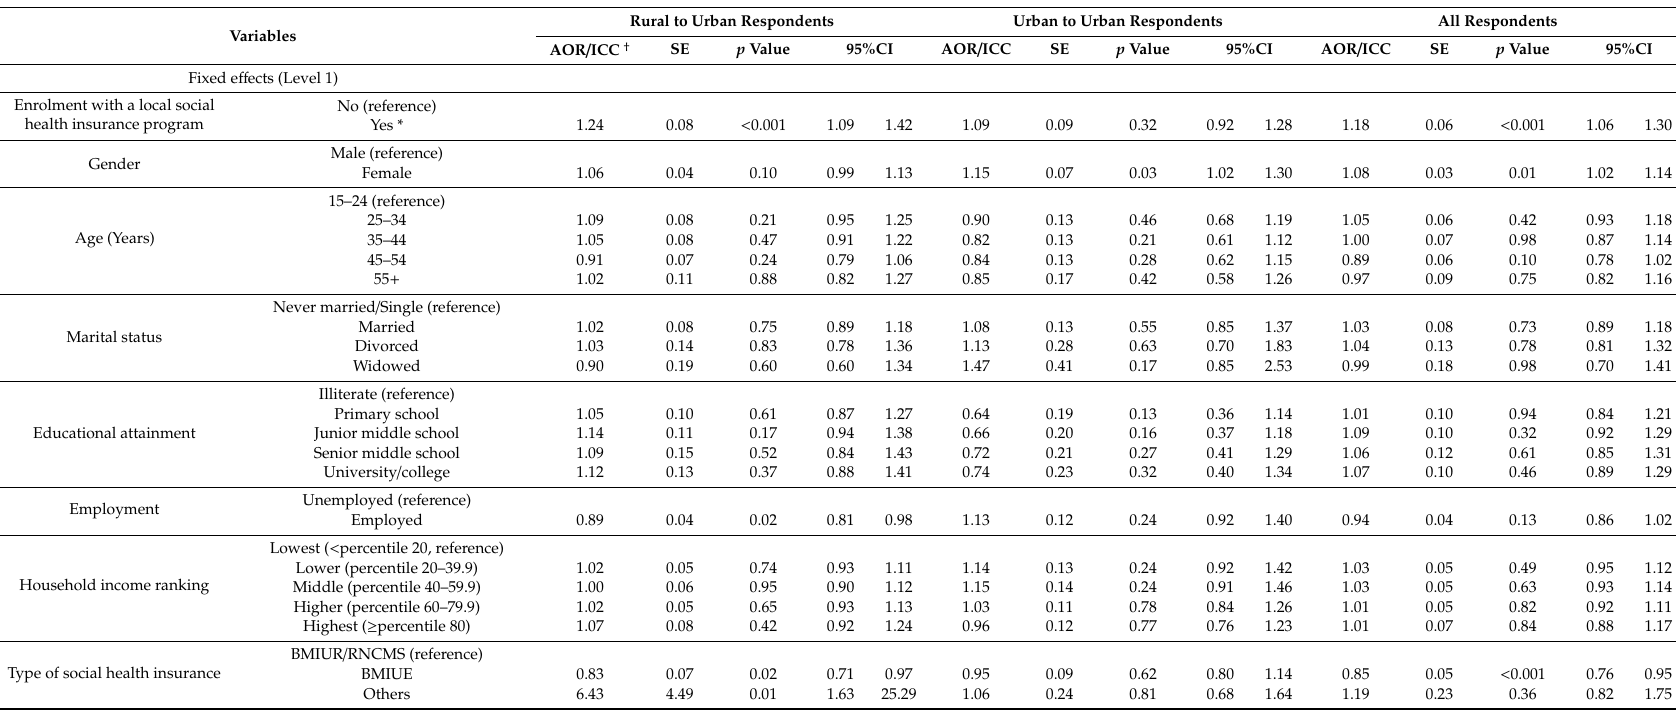
Table 3. Factors associated with visits to local physicians when needed: results of two-level logistic regression models. Rural to Urban Variables